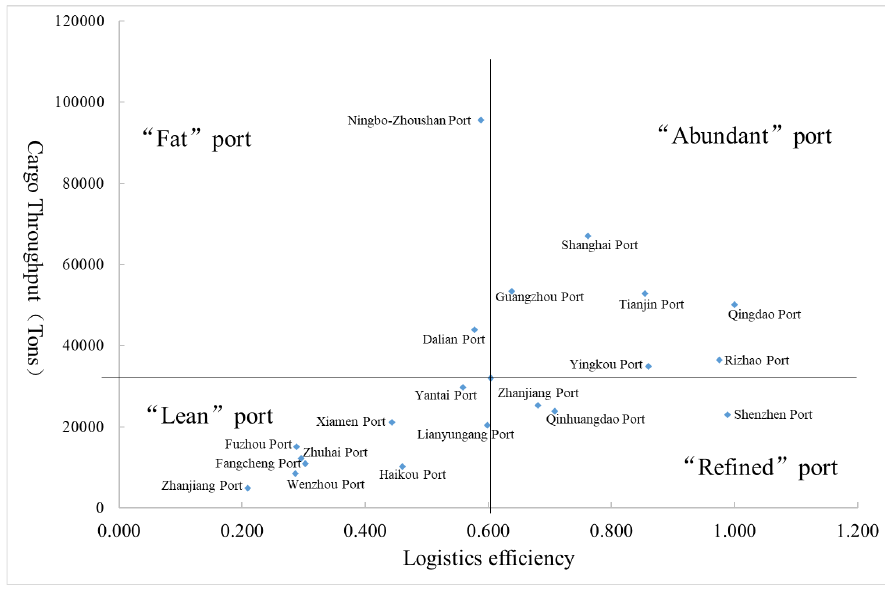
Figure 2. The port logistics efficiency throughput matrix.